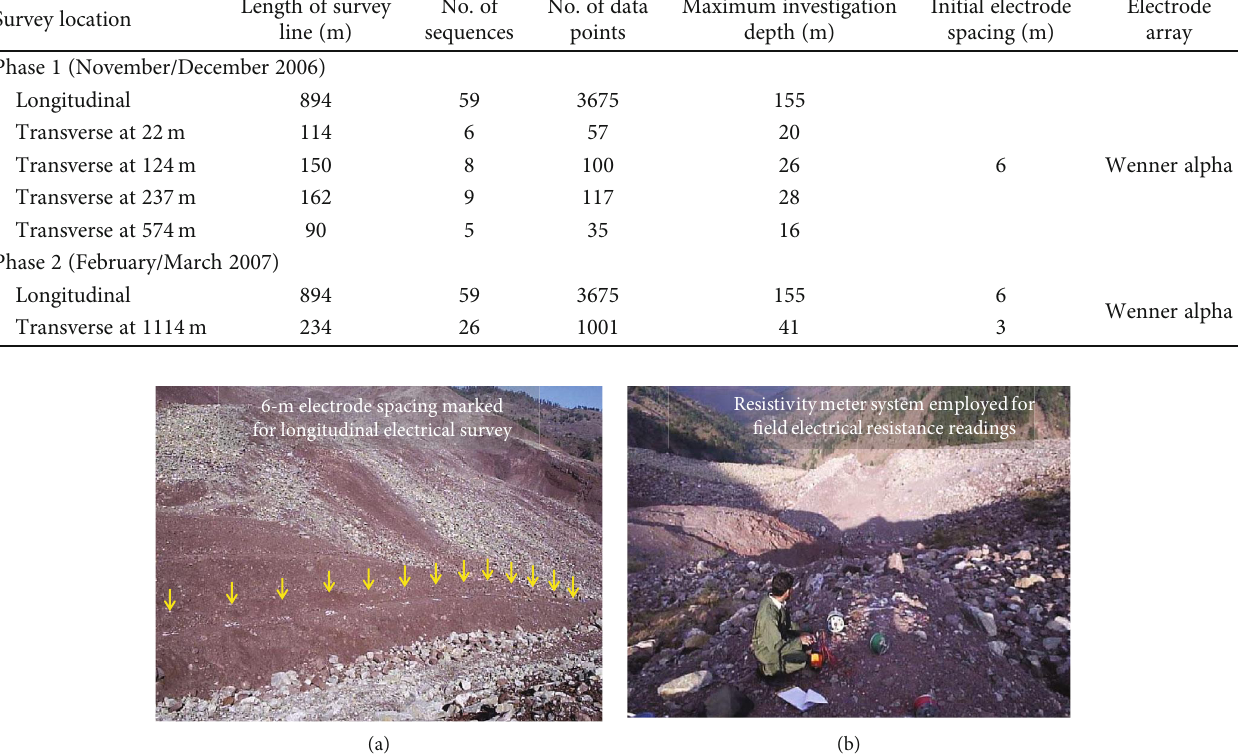
Table 1: Test parameters of the fi eld electrical resistivity surveys at the Hattian Bala landslide dam.